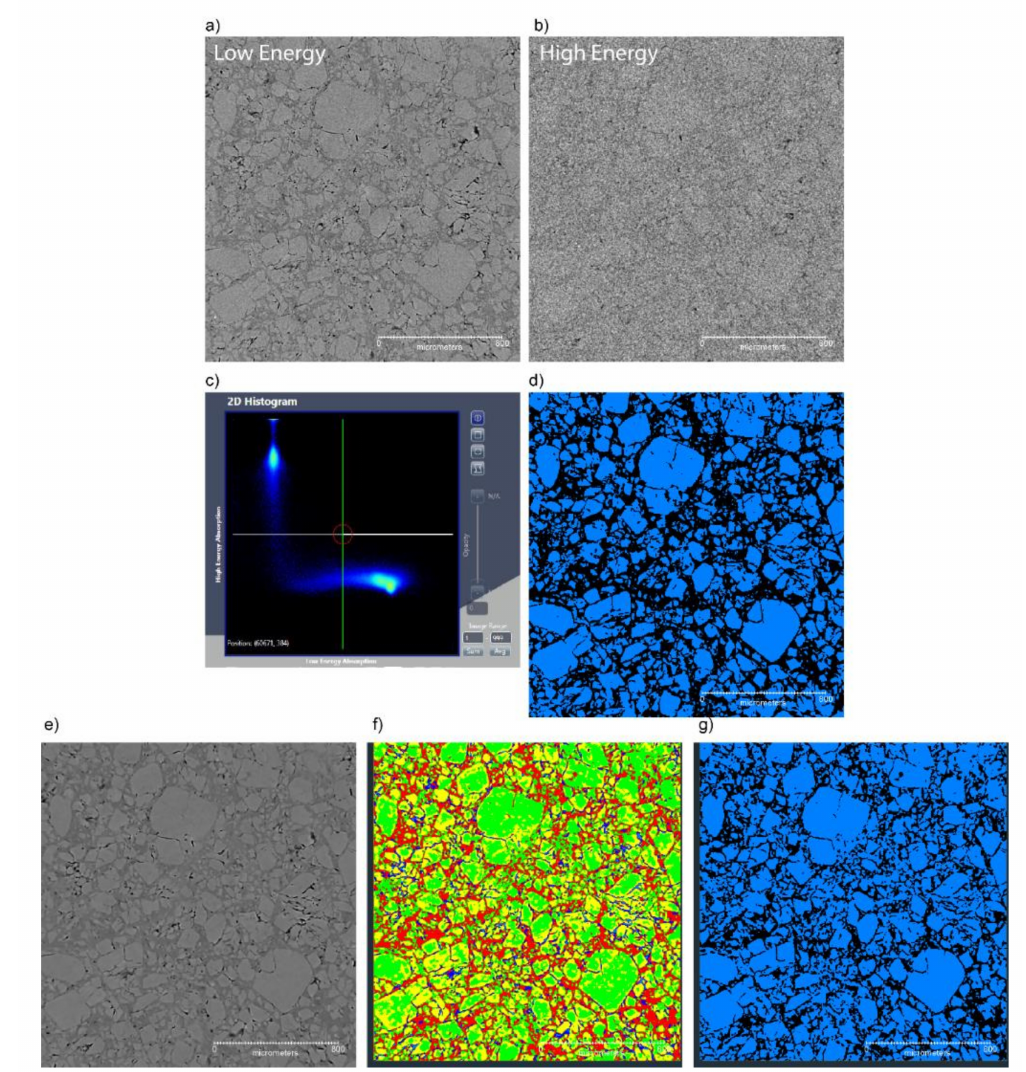
Figure 5. Segmentation attempts of PBX 9501 images using two di ff erent energies for the dual energy imaging technique, where ( a ) and ( b ) are the low energy and high energy reconstructed slices, and ( c ) is the 2D correlation plot of the high and low energy grayscale values used to select the crystals ( d ). The blob in the lower right is two unresolved spots; one represents the crystals, and the other is the binder; ( e ) is the output subpixel aligned low energy (SALE) image, sharpened, then segmented using the auto intensity calibration ( f ), and then finally segmented for the crystals ( g